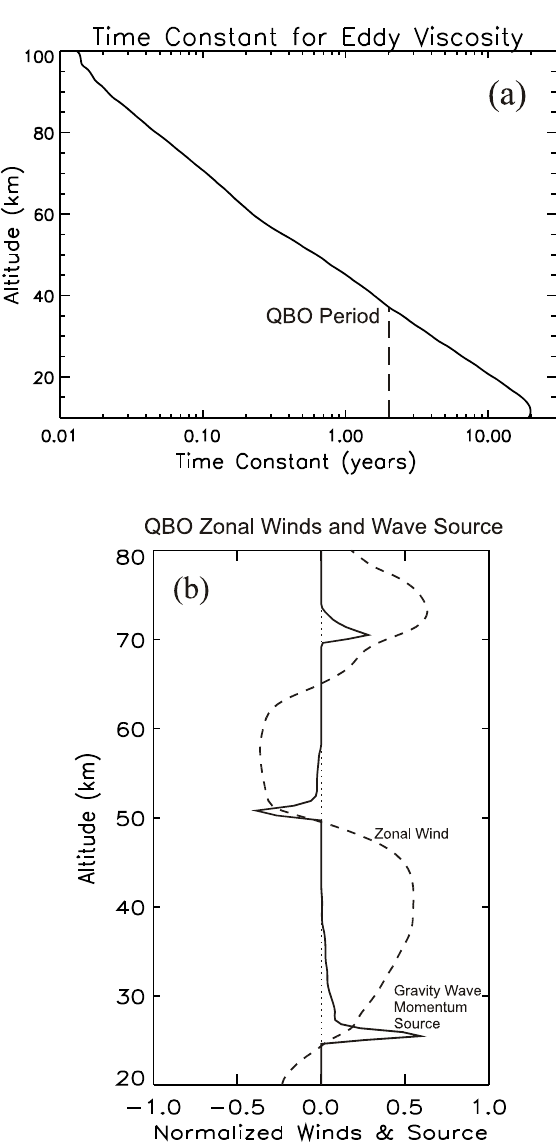
Fig. 1. (a) Time constant for the eddy viscosity obtained from the Doppler Spread Parameterization (DSP) of Hines applied in the model. Since the Coriolis force vanishes at the equator, the viscous stress essentially balances the GW momentum source at low lati- tudes, and the related time constant presented in the figure mainly determines the dissipation rate and period of the flow oscillation. In the lower stratosphere, the time constant is shown to be on the order of years, which is favorable for generating the long-term vari- ations induced by the solar cycle (SC). (b) Snapshots of normalized zonal winds and gravity wave (GW) momentum source plotted ver- sus altitude. The sharp peaks indicate a non-linearity with positive feedback, which is of critical importance for the SC mechanism dis- cussed. The sharp peaks of the GW source also characterize critical level absorption associated with planetary wave momentum deposi-